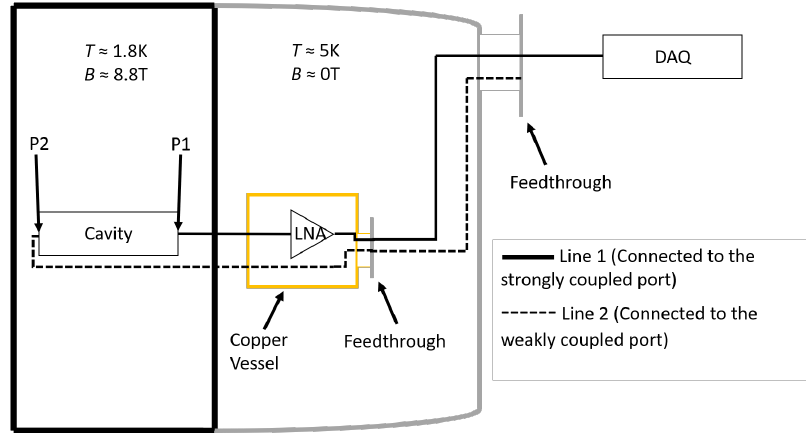
Figure 2 . Schematics of the CAST-RADES setup. The cavity is located inside one of the bores of the CAST magnet in a region with B ≈ 8.8 T at T ≈ 1.8 K. The critically-coupled port ( P 1 ) is connected through a coaxial cable to the LNA, which is located in a region with negligible magnetic field ( B (cid:28) 0 . 01 T ) at ≈ 5 K. The output of the LNA is connected through coaxial cables to a room temperature feedthrough and then to the DAQ. The weakly-coupled port ( P 2 ) is located at the rear part of the cavity and it is connected through coaxial cables to a room temperature